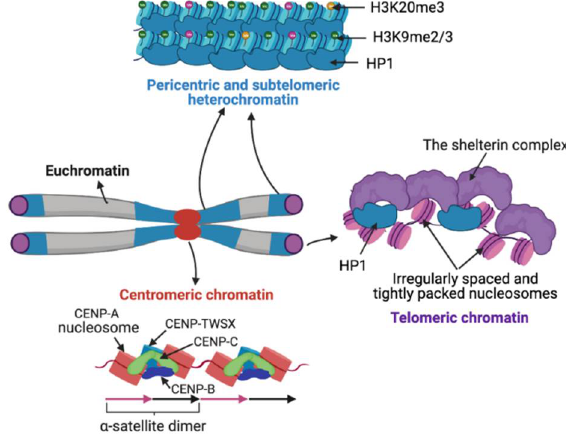
Figure 2. Satellite chromatin organization. In contrast to euchromatin, pericentric and subtelomeric regions are compact, marked by repressive modifications such as H3K9me3 and H3K20me3 and bound by Heterochromatin-associated Protein 1 (HP1). At centromeres, Centromere Protein A (CENP-A) nucleosomes form tight complexes with DNA binding centromeric proteins CENP-B, CENP-C and the histone-fold containing protein complex CENP-TWSX. Telomeric ends contain irregularly spaced and tightly packed nucleosomes separated by 10-20 bp DNA linkers. Telomeric chromatin is tightly associated with the shelterin complex and HP1.